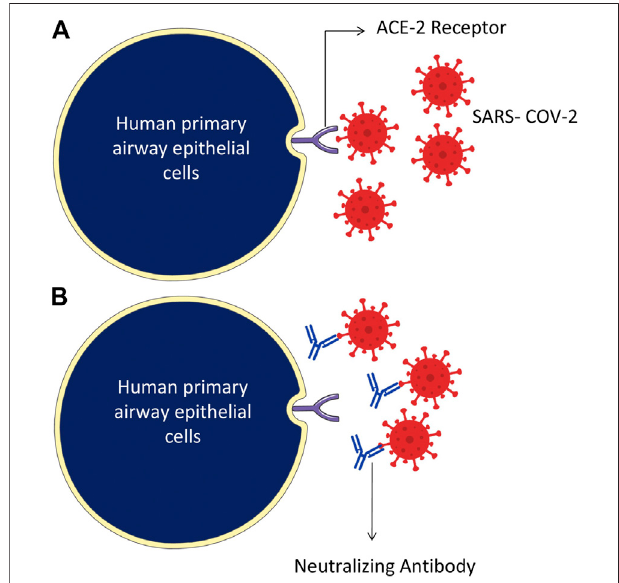
FIGURE 4 | Humanized monoclonal antibodies neutralize the SARS- CoV-2 virus, speci fi cally targeting by attaching to the RBD domain of spike proteinonthesurfaceofthevirus. (A) TheSARS-CoV-2bindsthroughRBDof the S protein and ACE-2 receptor of the host cells. (B) Humanized monoclonal antibodies bind with the virus spike proteins and neutralize